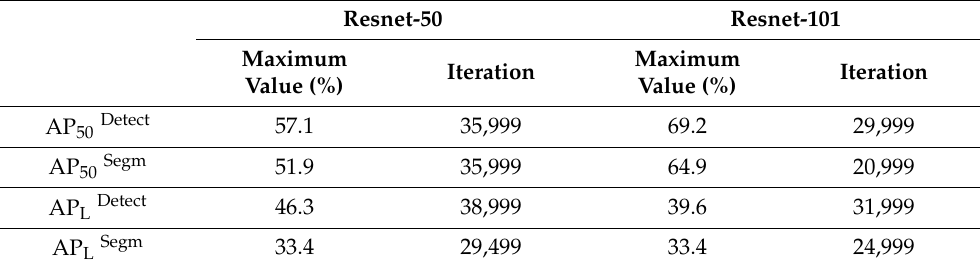
Figure 13. Training and validation curves for the loss function considering RoI IoU Head value equal to: ( a ) 0.55, ( b ) 0.57, and ( c ) 0.60. Table 7. Metrics values for backbone networks Resnet-50 and